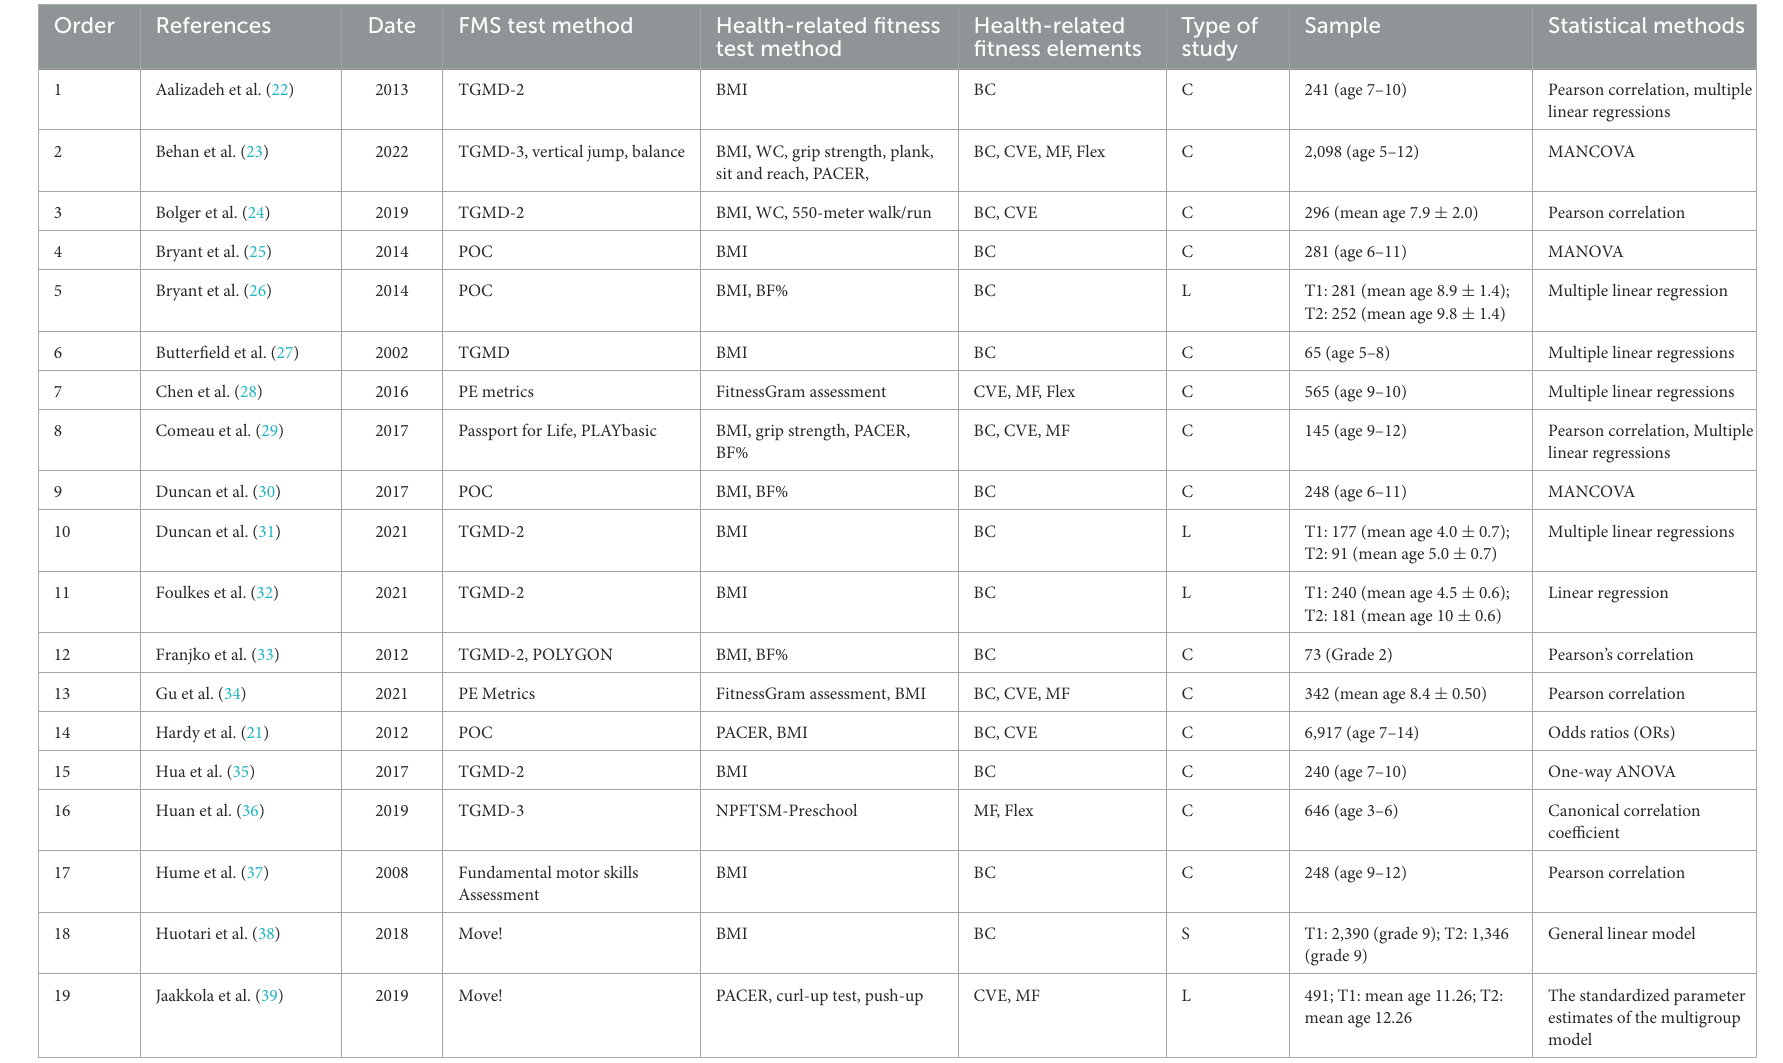
TABLE 1 Summary of the included